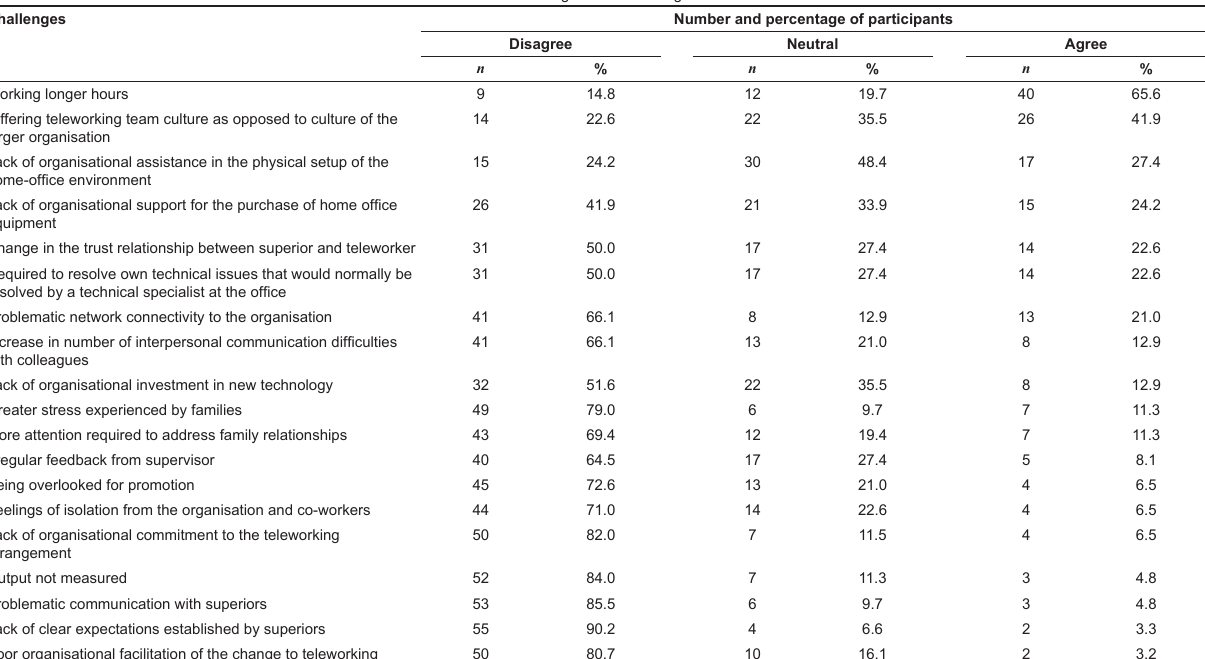
n = Number of participants. % = Percentage of